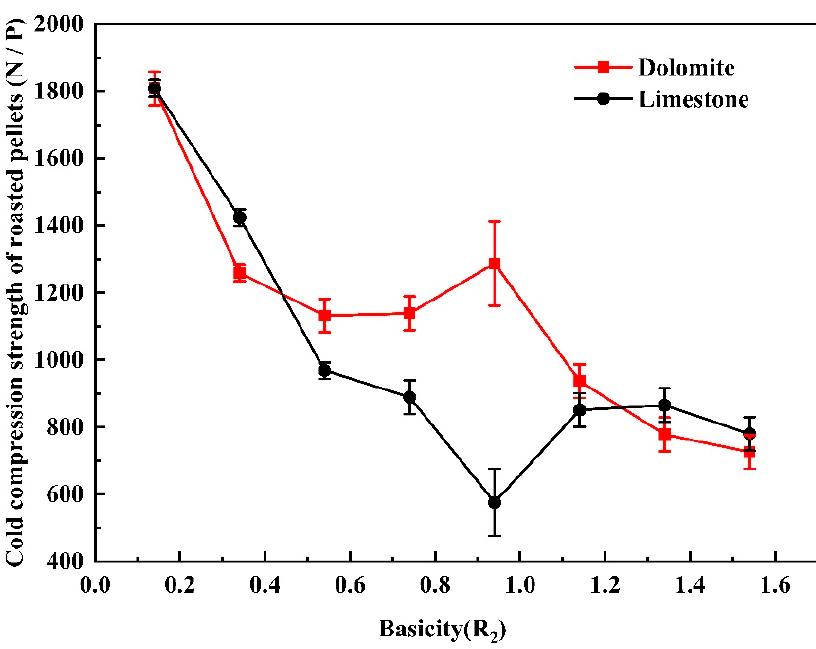
Figure 5. Effect of basicity and flux type on the cold compression strength of the roasted pellets.